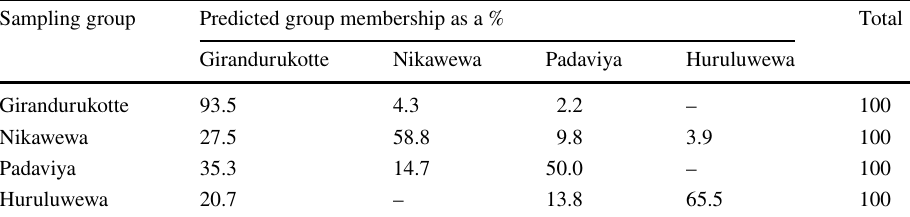
Table 12 Discriminant analysis results for secondary data